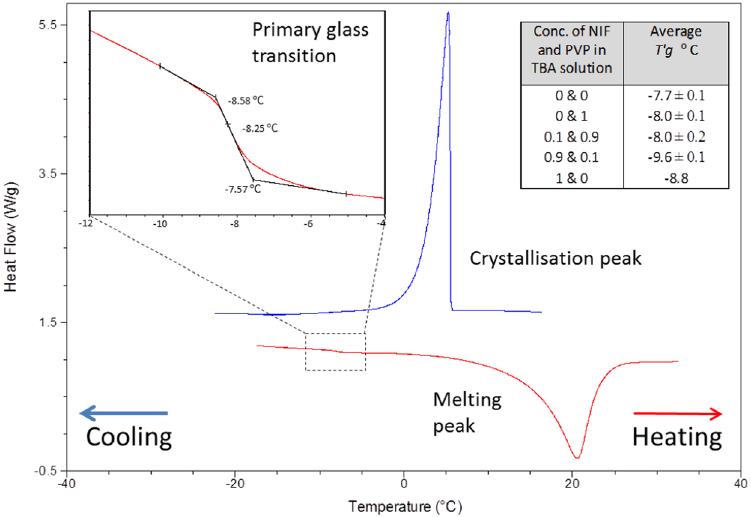
Figure 1. Thermogram of a liquid sample of NIF and PVP (with a target w/w percentage of 10% NIF in PVP) dissolved in TBA The sample was cooled to temperatures below − 20 °C and heated at a rate of 10 °C/min. T’ g determined to be − 8.3 °C. Table in top right corner presents average T’ g values of feed solutions containing highest and lowest concentrations, in % w/v, standard deviation, ± , is shown for n =